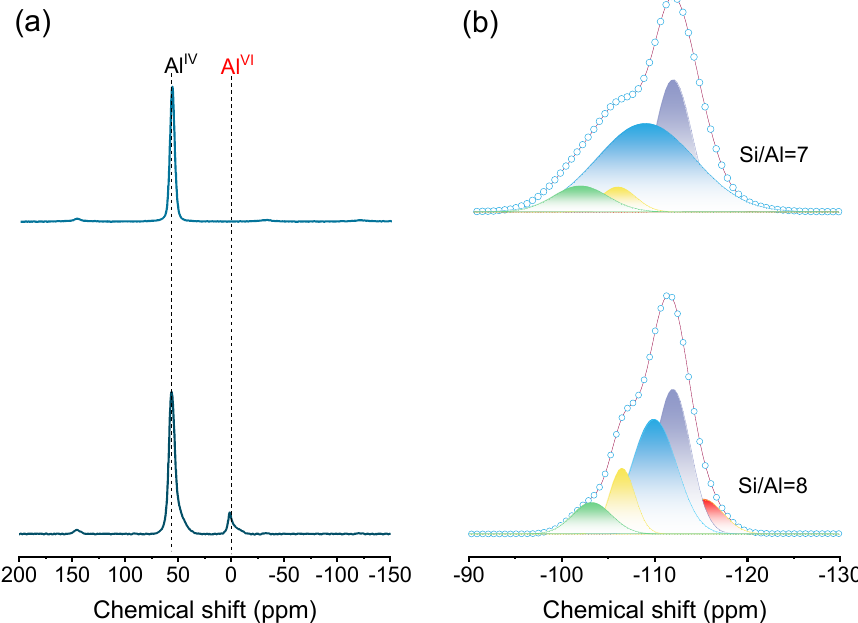
Table 2. Relative peak areas of the 29 Si MAS NMR spectra of the Z5-PK3.